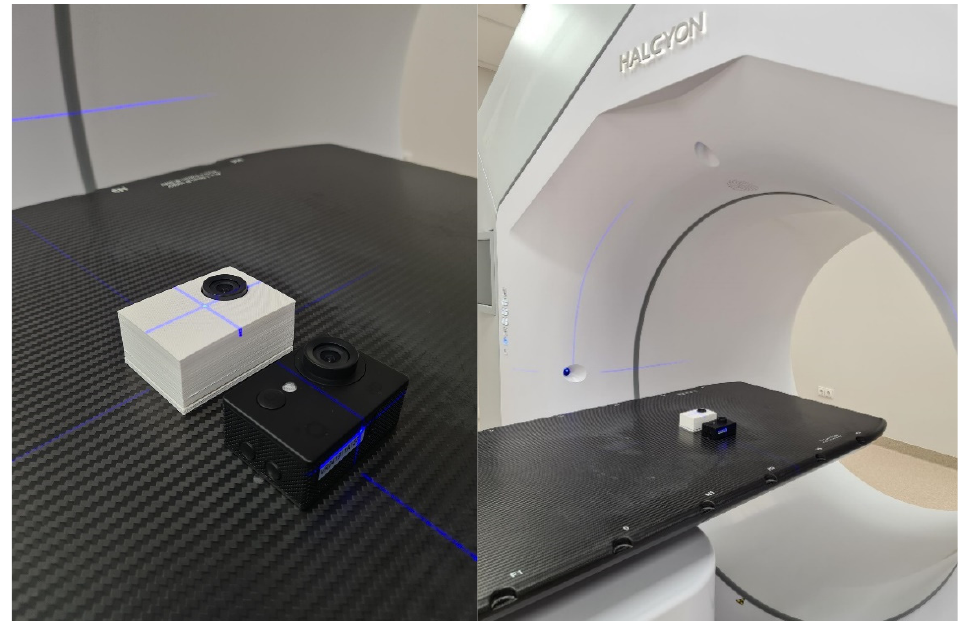
Figure 4. Irradiation of two cameras with and without protective casing, using a linear accelerator.